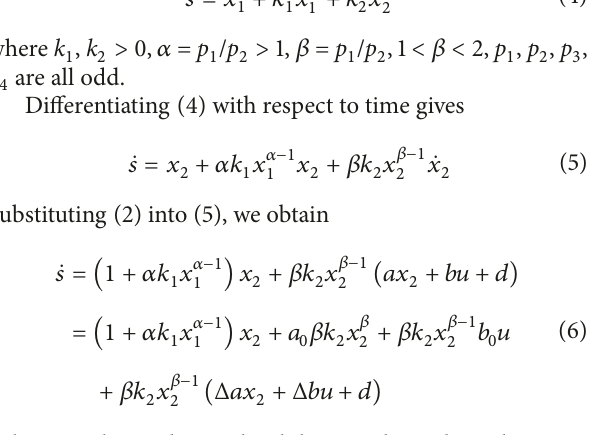
𝜂 are the LOS dip angle and slip angle, respectively. V are the speeds of the missile and the target, respectively. 𝜃 m and 𝜑 m represent the missile ballistic dip angle and slip angle, respectively. 𝜃 t and 𝜑 t are the target track dip angle and slip